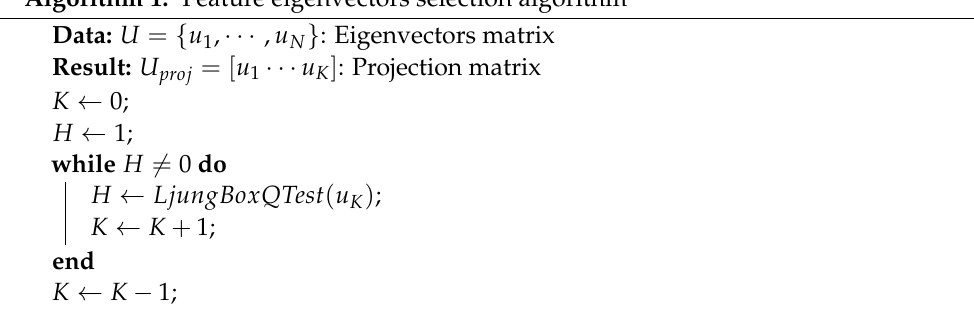
Algorithm 1: Feature eigenvectors selection